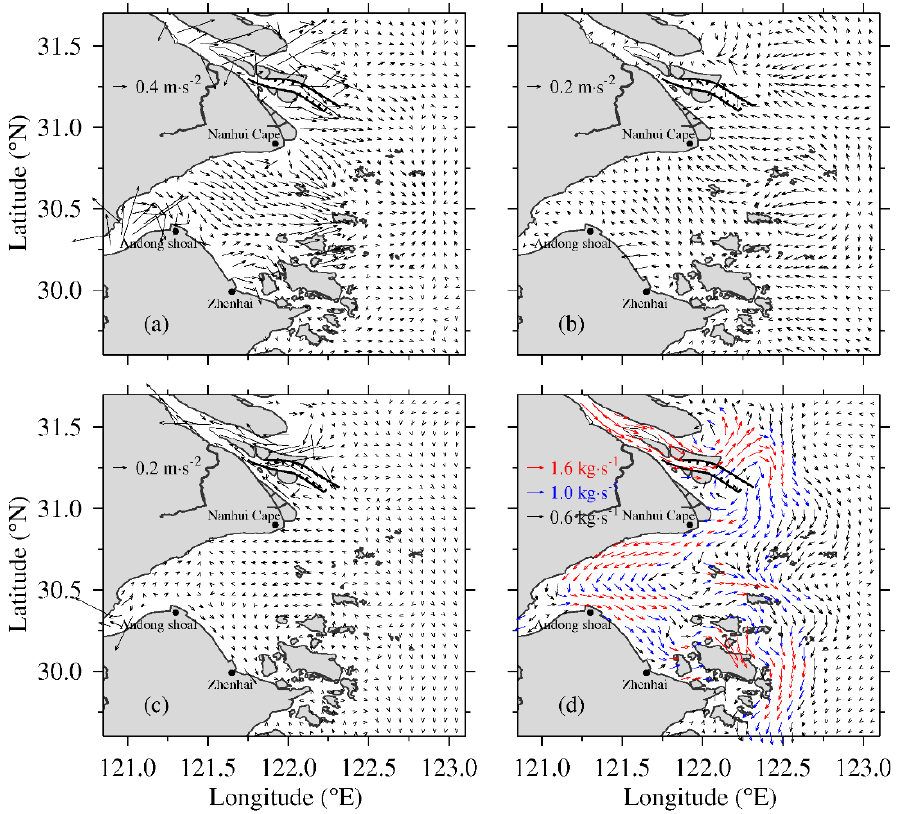
Figure 18. Distribution of tidally averaged barotropic pressure gradient force ( a ), vertically averaged baroclinic pressure gradient force ( b ), resultant force of wind stress and bottom friction ( c ), and the RUSF in the whole layer without baroclinic pressure gradient force ( d ) during spring tide in sum- mer.